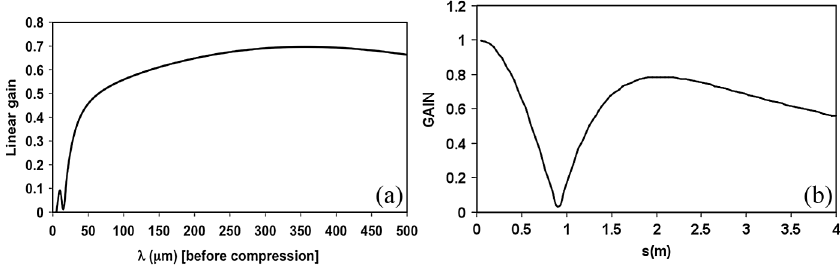
FIG. 4. (a) Linear gain at the exit of the rf compressor. (b) Linear gain as a function of the longitudinal position for a selected ( (cid:5) ¼ 100 (cid:12) m ) modulation wavelength.